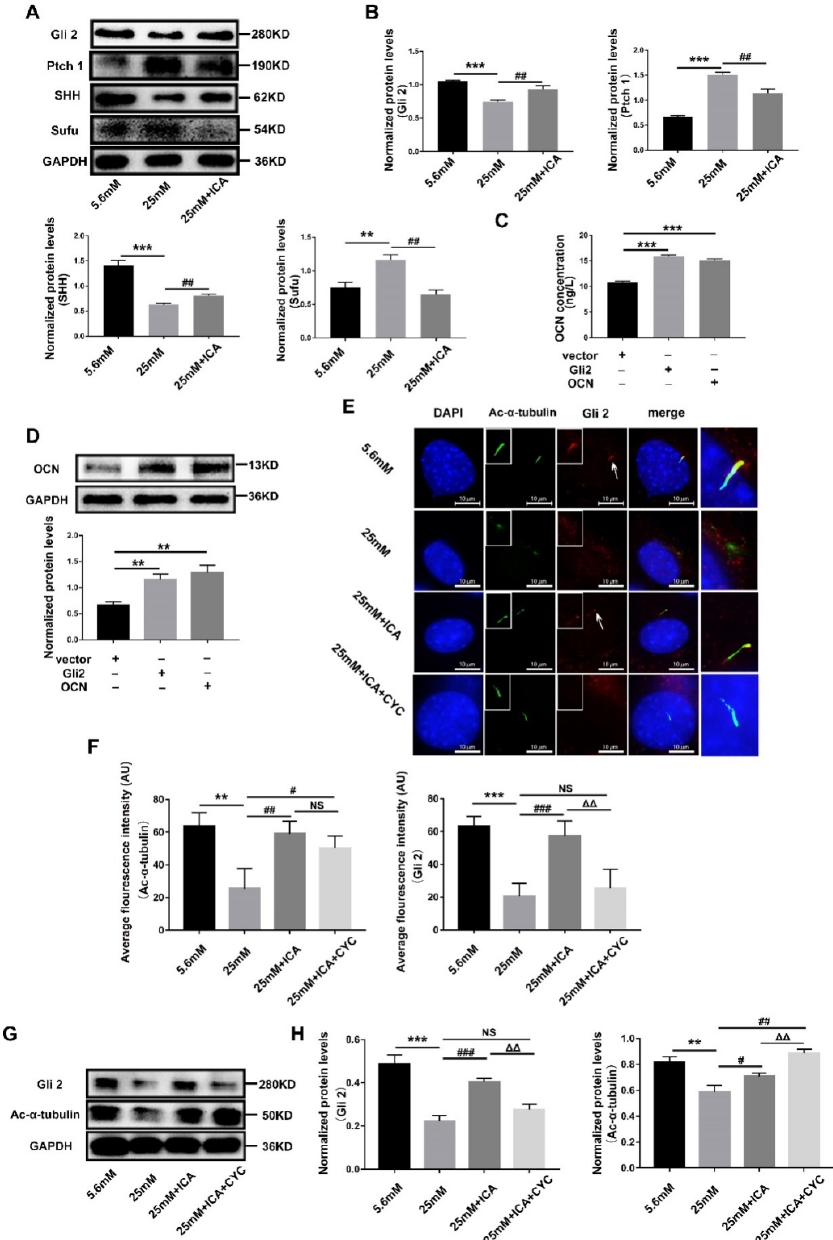
Figure 5. ICA activates Hedgehog signaling by maintaining primary cilia localization of Gli2. MC3T3-E1 cells were induced in different conditions for 3 days, extracted total cell protein. ( A ) Western blot detected Hedgehog signaling proteins Gli2, Ptch1, SHH and Sufu. ( B ) Quantitative analysis the protein expression level in ( A ). Overexpression Gli2 or OCN in HEK-293T cells, ELISA ( C ) and western blot ( D ) detected OCN protein. ( E ) Immunofluorescence observed primary cilia and Gli2 location. ( F ) Quantitative analysis average fluorescence intensity of Ac- α -tubulin and Gli2 in ( E ). Extracted total cell protein, ( G ) Western blot detected Gli2 and Ac- α -tubulin. ( H ) Quantitative analysis the protein expression level in ( G ). ** p < 0.01 and *** p < 0.001, compared with 5.6 mM group. # p < 0.05, ## p < 0.01 and ### p < 0.001, compared with 25 mM group. ∆∆ p < 0.01, compared with 25 mM + ICA group. NS: no